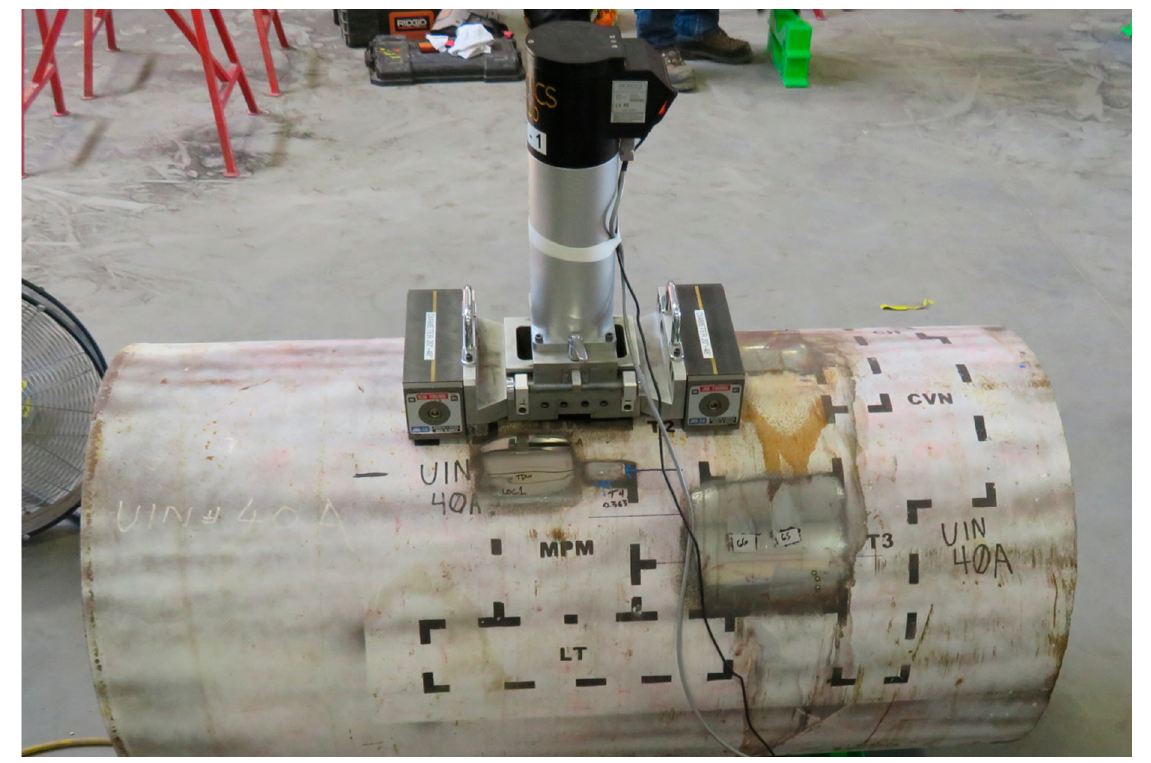
Figure 1. Photograph of the Frontics AIS 2100 IIT instrument mounted to a pipe sample.